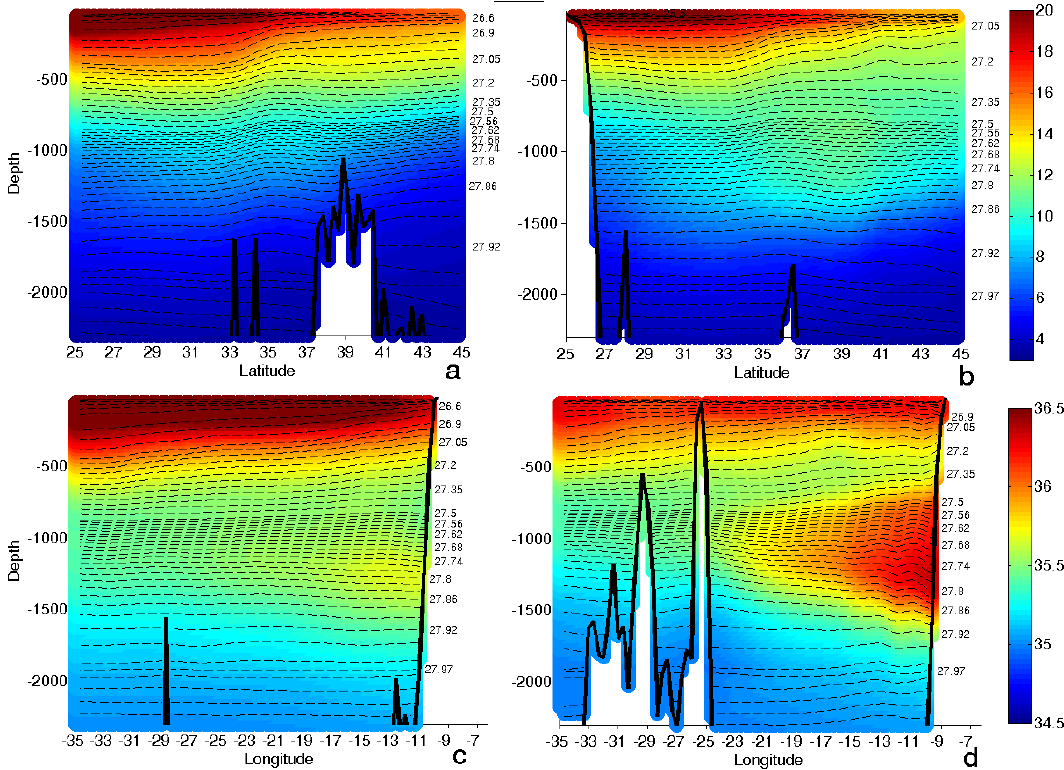
Figure 5. Vertical meridional sections of temperature along (a) 30 ◦ W and (b) 15 ◦ W, and zonal sections of salinity along (c) 31 ◦ N and (d) 38 ◦ N. The dashed isolines show positions of neutral density surfaces (some of the surfaces are identified to the right of the